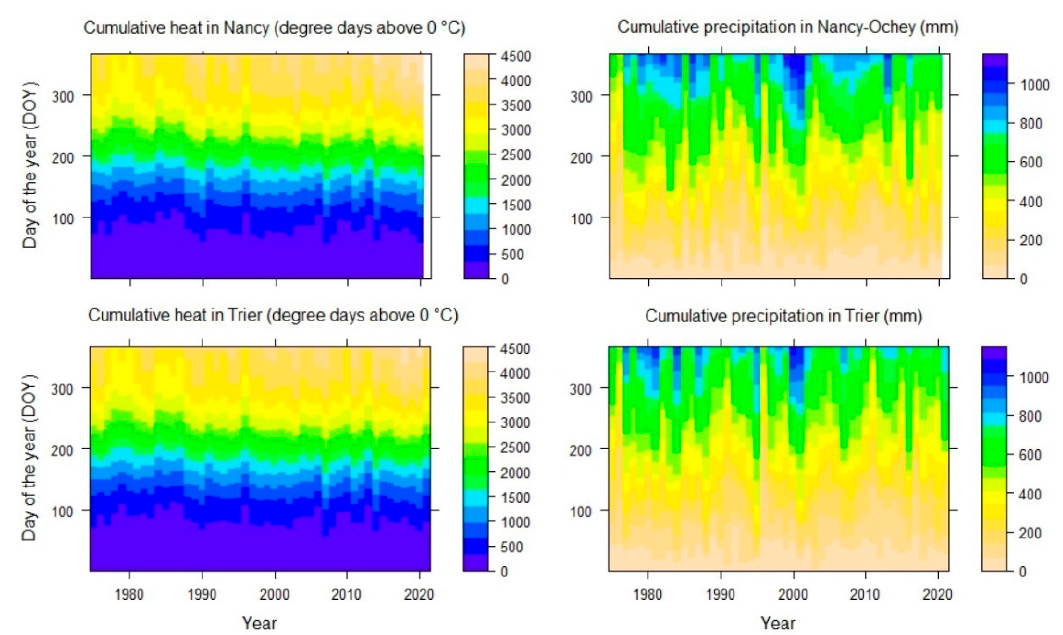
Figure 3. Accumulated heat sums (daily temperature means above 0 ◦ C) between 1975 and 2020 ( x -axis) in Nancy ( top ) and Trier ( bottom ) and the accumulated annual precipitation at those stations ( right ). The values are summed up from 1 January (DOY 1) to 31 December ( y -axis).